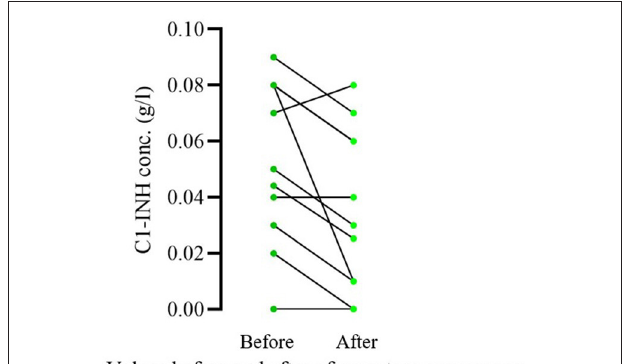
FIGURE 1 | Comparison of C1-INH concentration prior vs. after the onset of symptoms in pediatric patients diagnosed as a result of family screening. Only patients who became symptomatic during the follow-up period and had complement results in the 1 year before and after symptom appearance were included in this analysis (11/16). Significantly lower C1-INH concentrations were detected ( p = 0.0078) after the onset of symptoms in these patients.